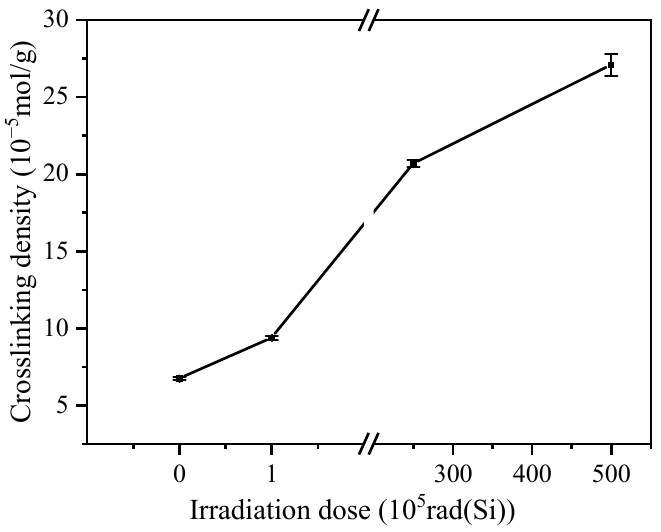
Figure 16. Crosslinking density.